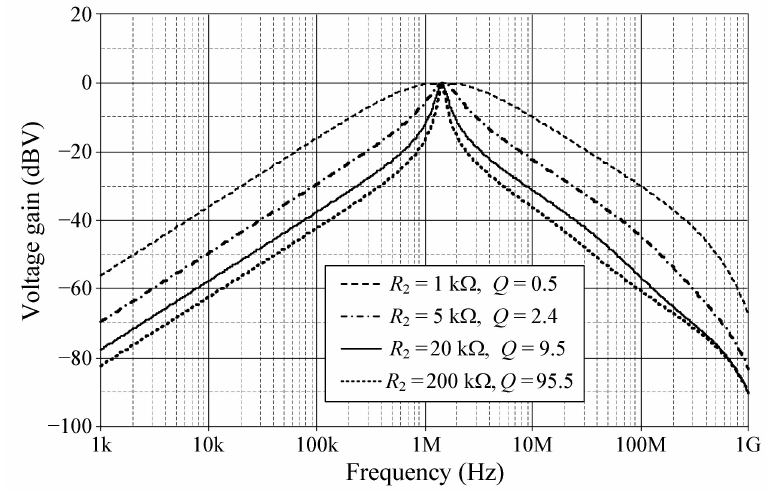
Figure 10. Simulated BP gain responses in VM for variation in Q with f o = 1.52 MHz.